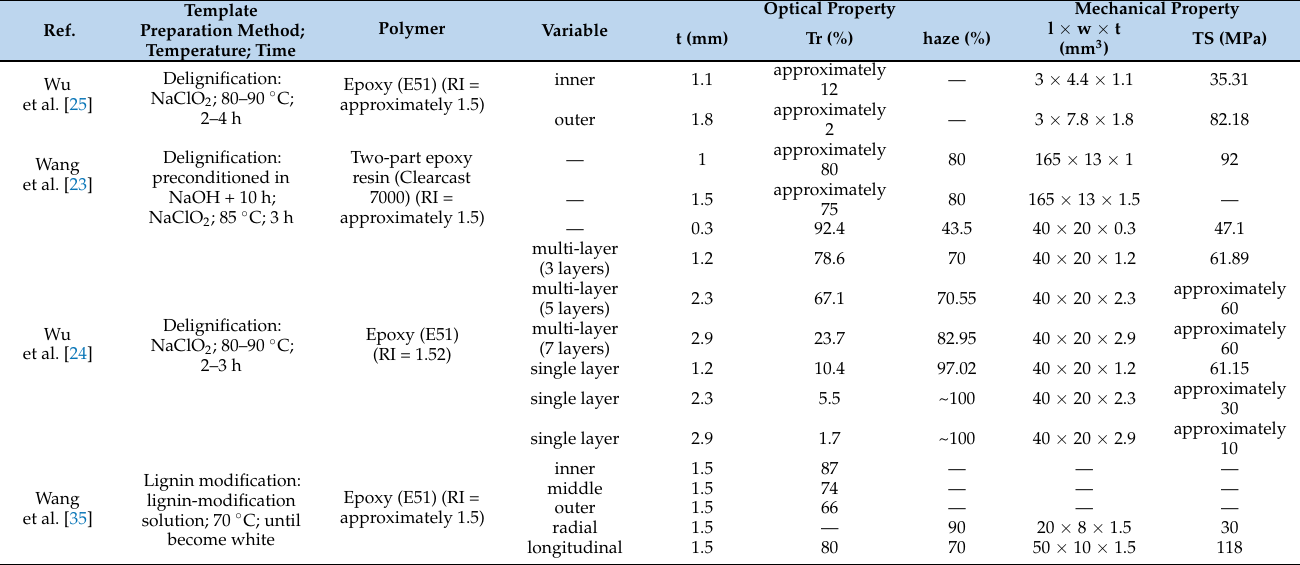
Table 1. Summary of TB preparations and properties.